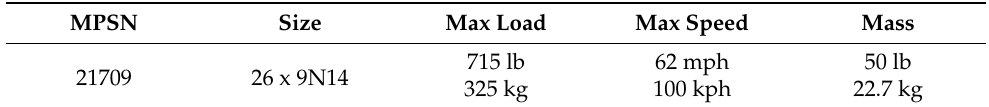
Table 1. Michelin X-Tweel UTV technical